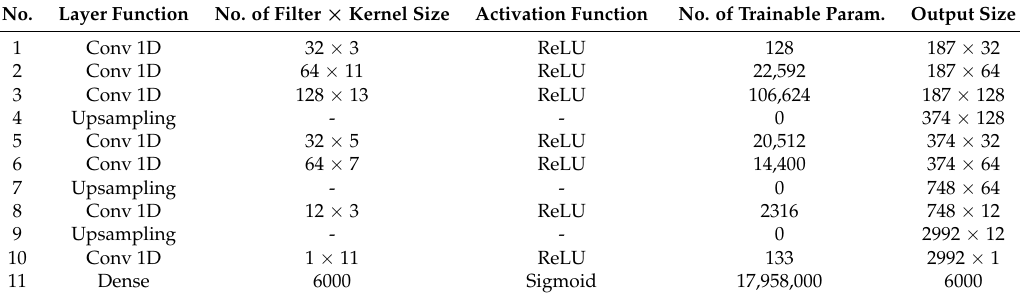
Table 2. Detail parameters for each layer in the proposed